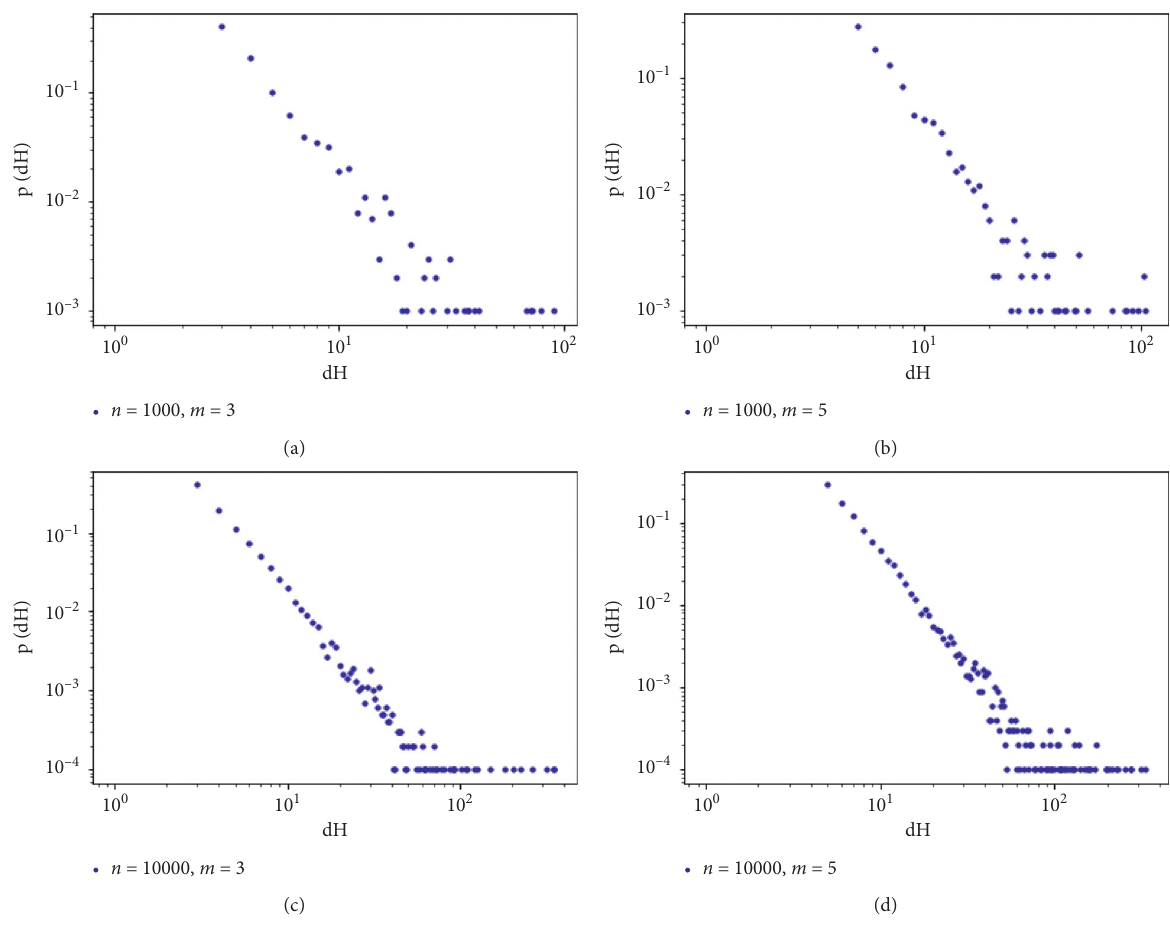
Figure 7: Double logarithmic hyperdegree distribution diagram.